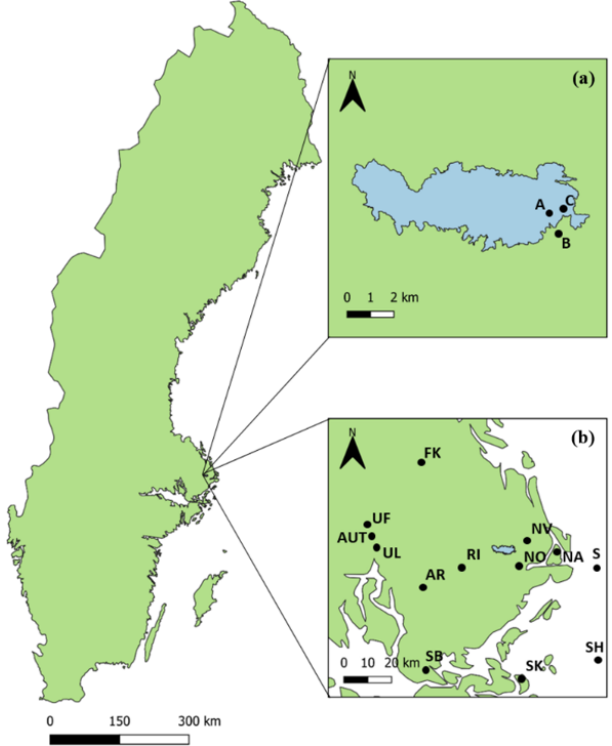
Figure 1. (a) Location of meteorological and floating stations within the Lake Erken basin and catchment area. Letter A shows the position of Erken laboratory meteorological station (Malma islet, 59.83909 ◦ N, 18.62956 ◦ E), letter B identifies Svan- berga SMHI weather station (59.8321 ◦ N, 18.6348 ◦ E), and let- ter C represents the position of the floating station that records water temperature data. (b) Location of the SMHI (Swedish Meteorological and Hydrological Institute) and SLU (Swedish Agricultural University) meteorological stations from which in- put data have been retrieved to run the model. SMHI sta- tions: AR: Arlanda (59.6557 ◦ N, 17.9462 ◦ E), AUT: